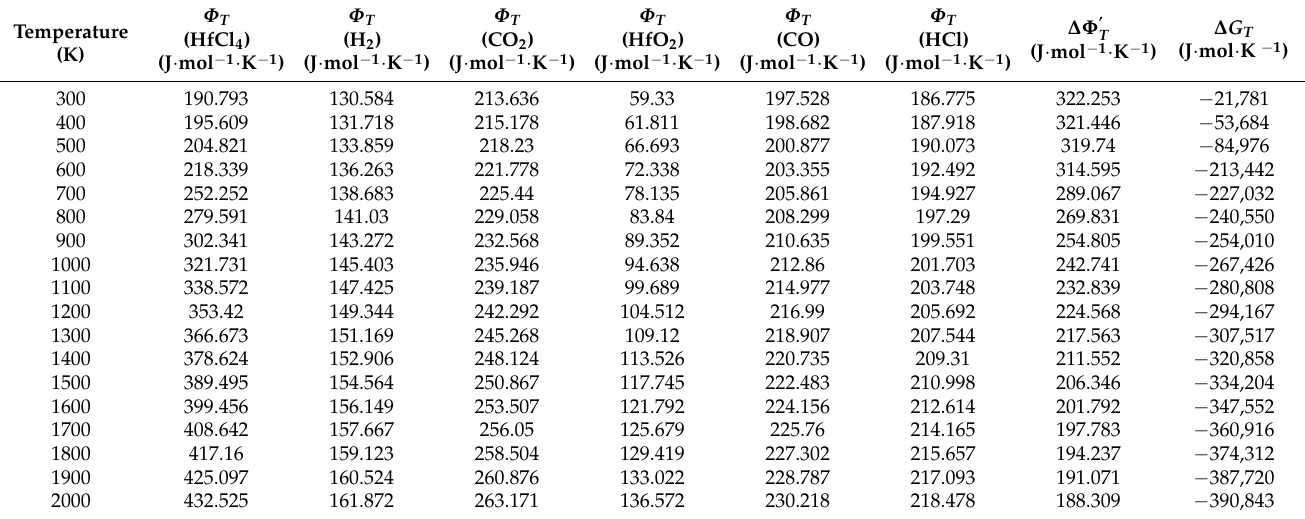
Table 1. Reactants’ Gibbs free energy function and Gibbs free energy function of the reaction when HfCl 4 , H 2 , and CO 2 react to generate HfO 2